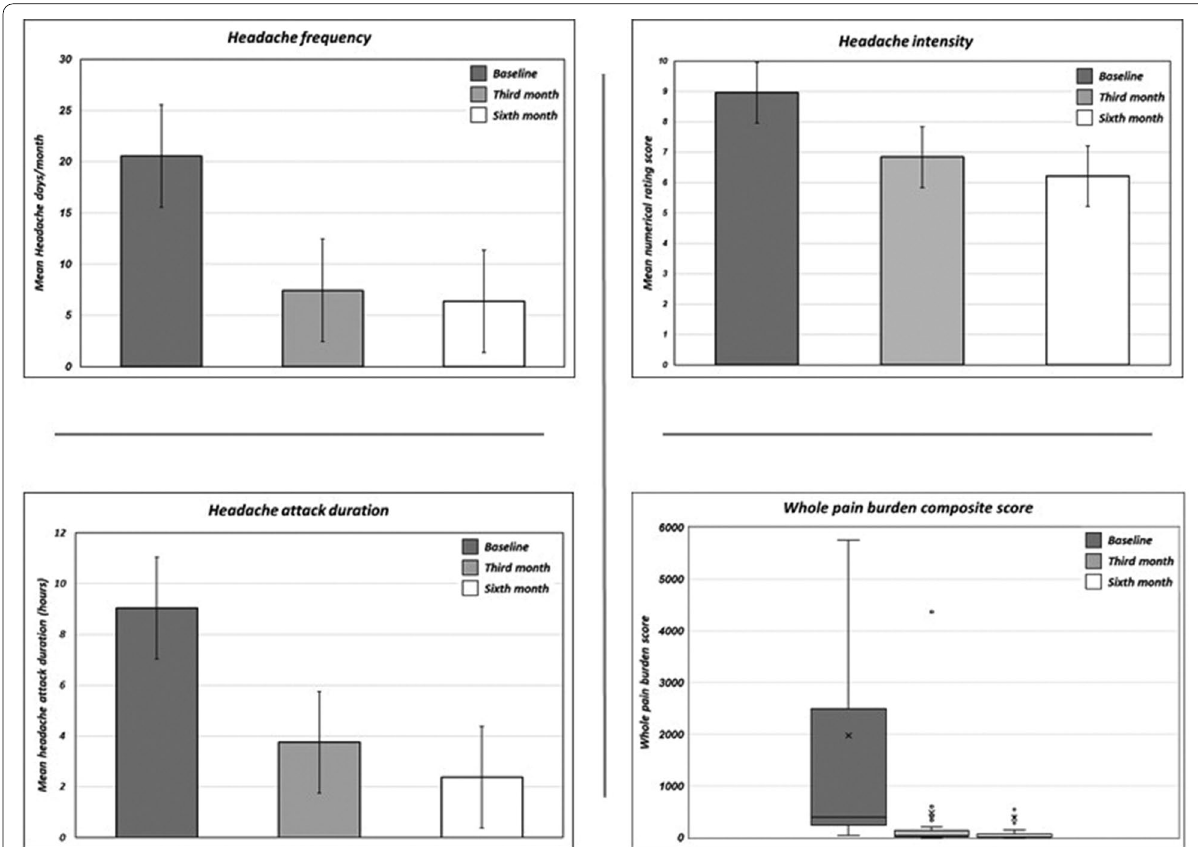
Fig. 1 Primary outcome: headache attacks frequency, intensity, duration and “whole pain burden” score at baseline (T 0 ), and at the end of the third (T 1 ) and sixth month (T 2 ) of galcanezumab